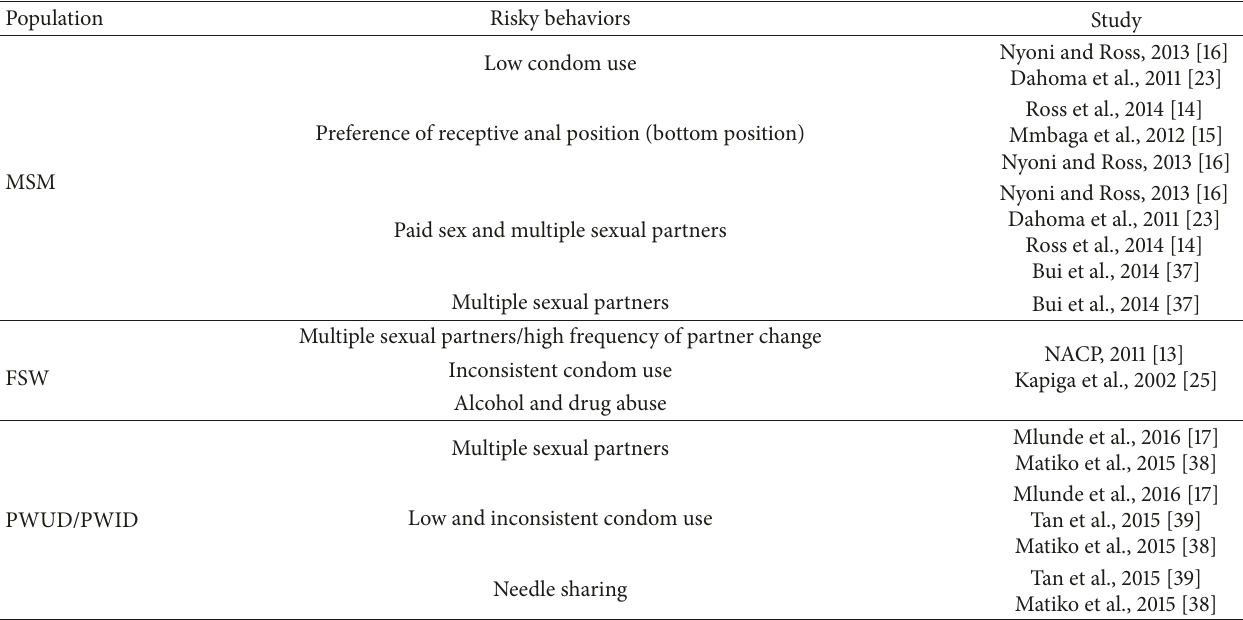
Table 2: Summary on risky behaviors and the respective studies among the key populations in